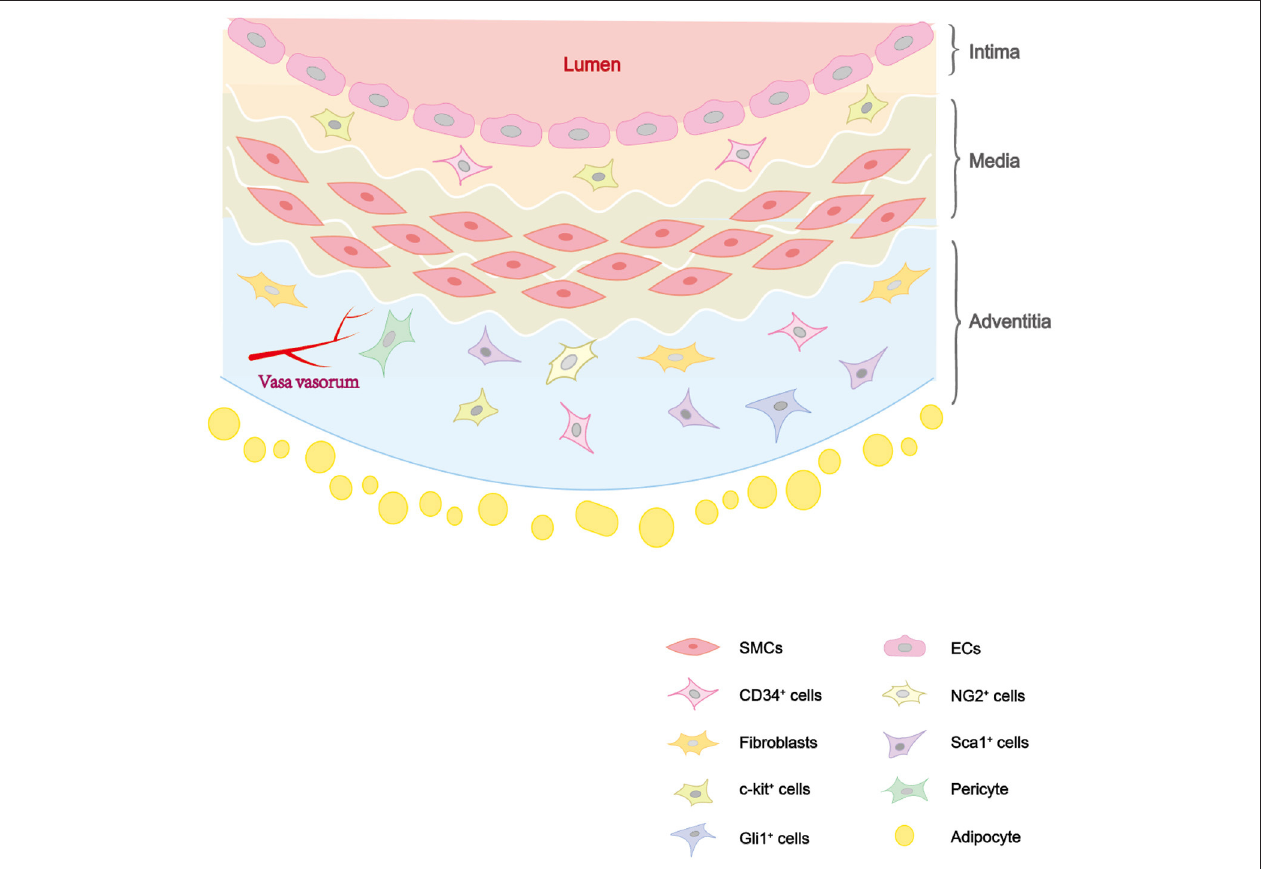
FIGURE 1 | The distribution of cells in vascular wall. The vascular wall consists of three layers: intima, media, and adventitia. The intima consists of ECs and some vascular stem cells such as c-kit + cells. The media is composed of SMCs. The adventitia is composed of vascular stem cells (Sca-1 + cells, c-kit + cells, CD34 + cells, pericytes, etc.) and